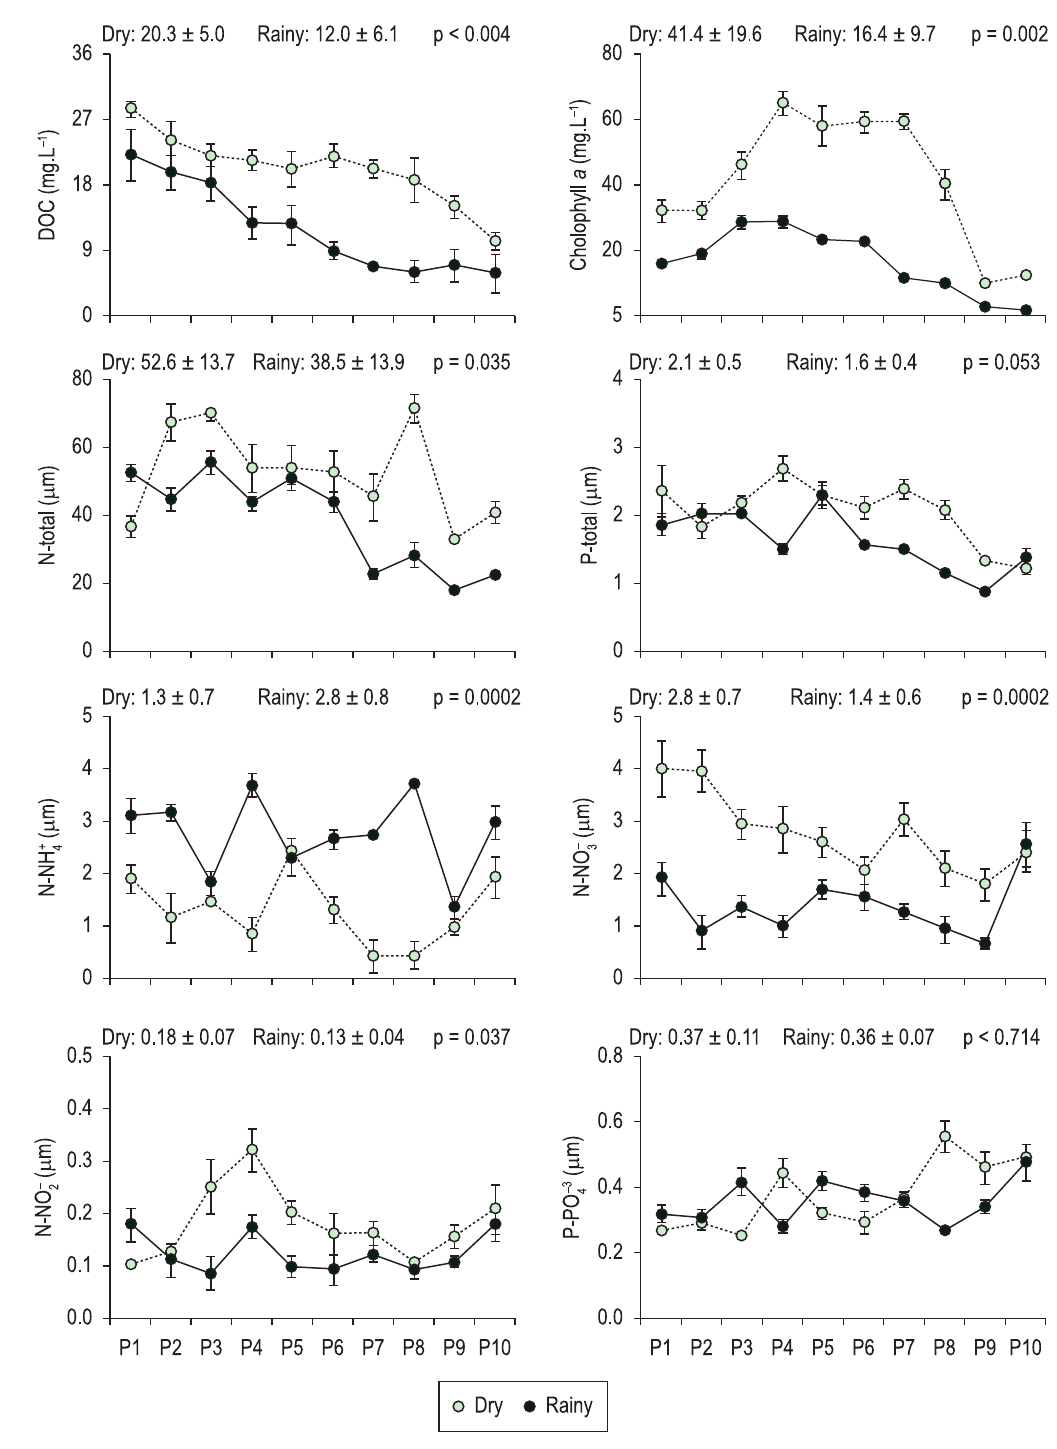
Figure 3. DOC, chlorophyll- a , N-total, P-total, ammonium, nitrate, nitrite and orthophosphate in Campelo Lagoon in dry (July/2001) and rainy (January/2002) season. The vertical bars represent the standard deviation. Mean ± standard deviation values for each season and significance